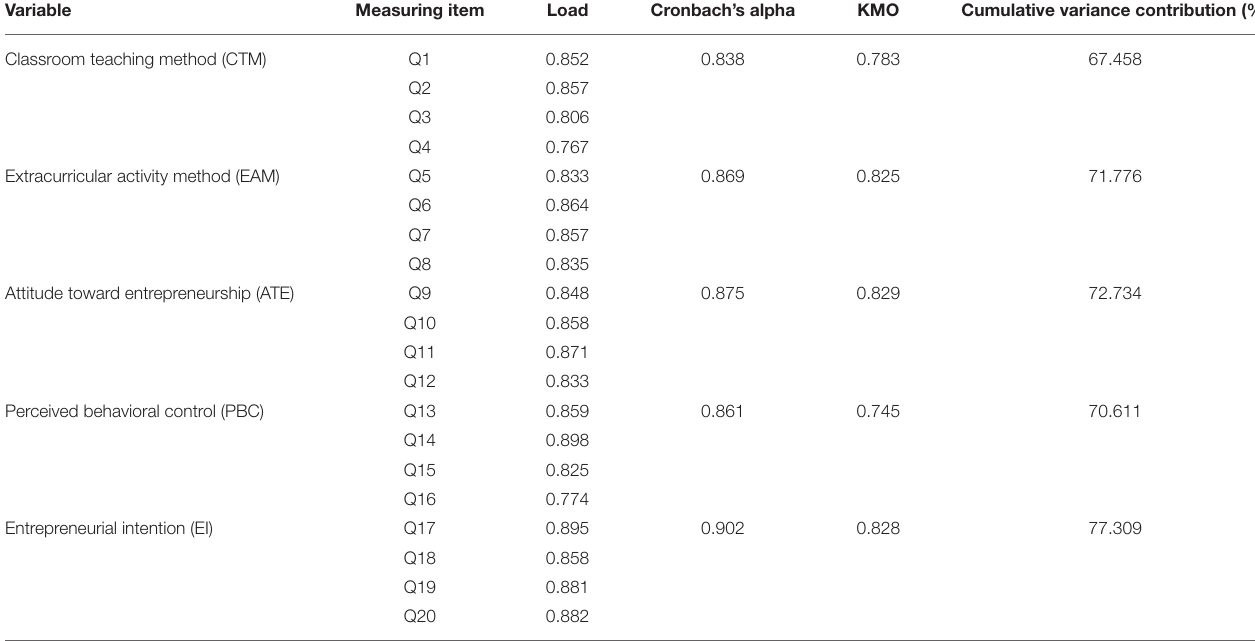
TABLE 3 | Results of exploratory factor analysis ( N = 514).